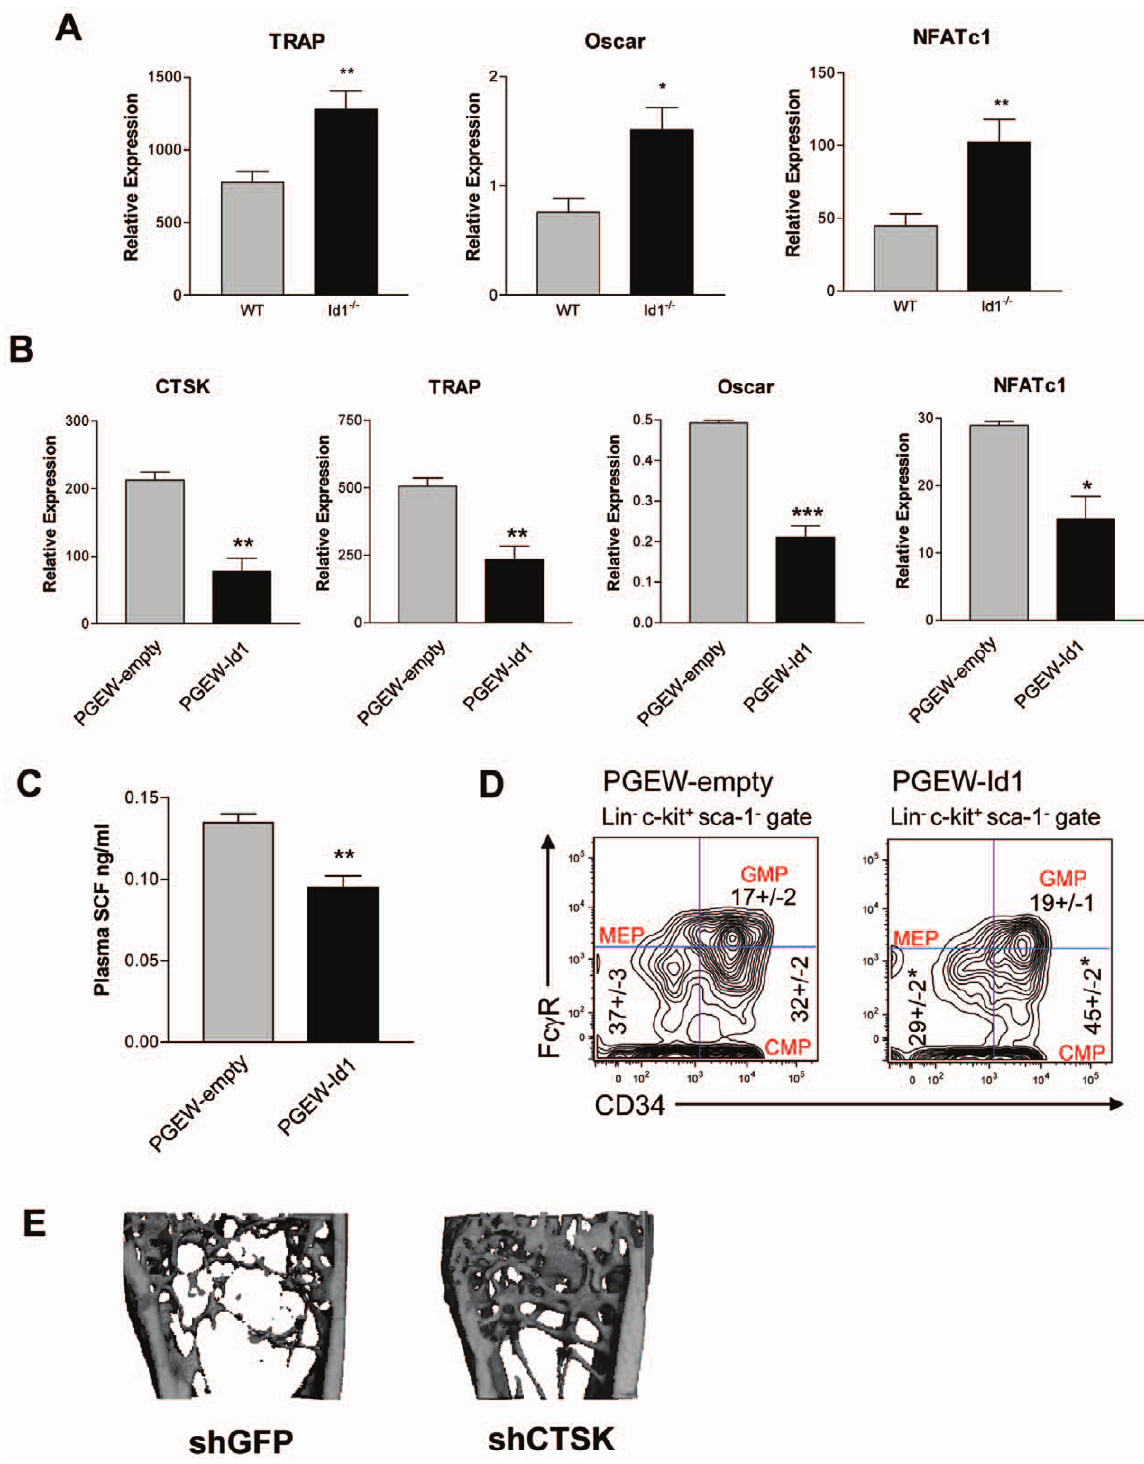
Figure 6. A proposed mechanism for Id1 function in the BM microenvironment. (A) Expression of osteoclast-associated genes, TRAP , Oscar , and NFATc1 in the BM of wild-type and Id1 2 / 2 mice (n=6). (B) Expression of osteoclast-associated genes from the BM of transplanted mice (n=6). Lin 2 BM cells from Id1 2 / 2 mice were transduced with lentivirus containing PGEW-Id1 or PGEW-empty vector overnight and transplanted into Id1 2 / 2 mice. After 8 weeks, the mice were sacrificed and BM from the femur was collected for qPCR analysis. (C) SCF levels in plasma assayed by ELISA. (D) Representative flow-cytometric profiles of myeloid progenitor populations (CMP, GMP, MEP) in mice transplanted with PGEW-Id1 or PGEW-empty BM (n=6). (E) Representative micro-CT images of the femoral distal trabecular region in Id1 2 / 2 mice transplanted with BM containing a shRNA targeted against CTSK or GFP. (A-D) *P , 0.05, **P , 0.01, ***P , 0.001. Error bars represent 6 S.E.M.